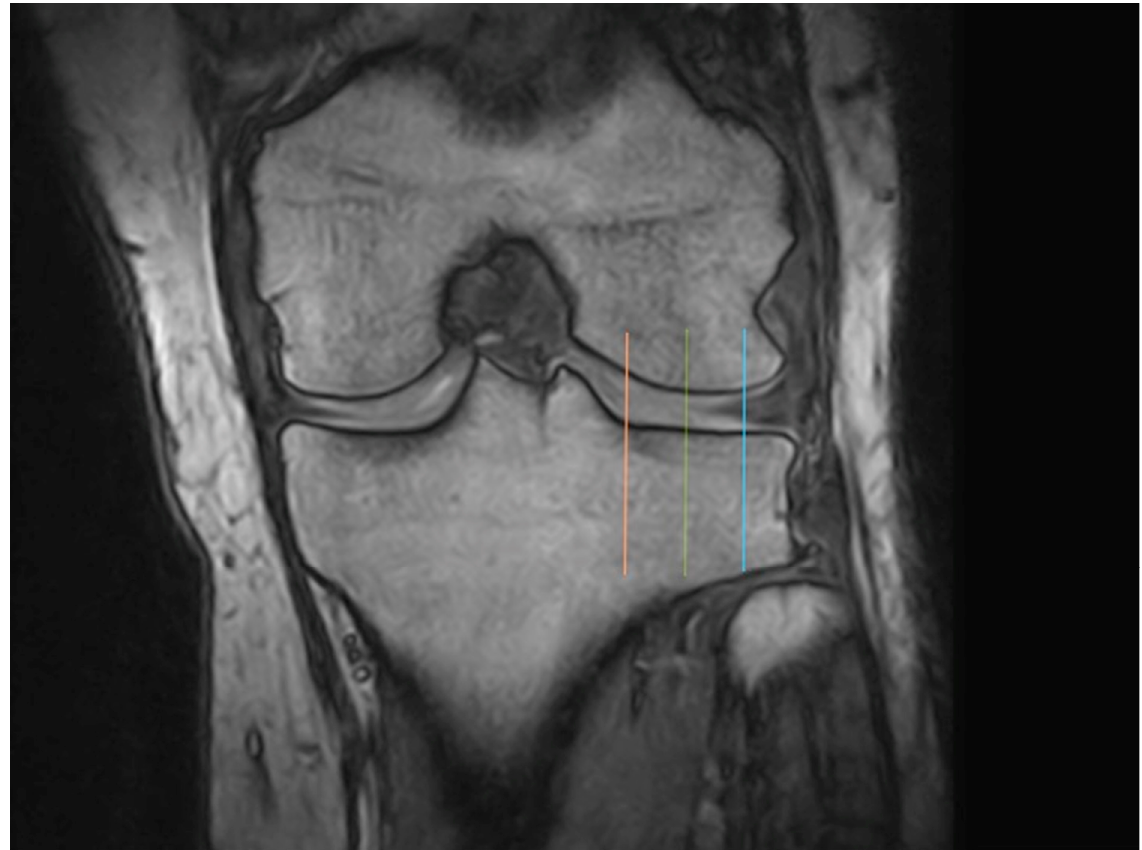
Figure 2. The plane and points of measurements for femoral and tibial condyles include three reference points in frontal view: center of the condyle (green line); 5.7 mm medial from the midline (orange line); and 5.7 mm lateral to the midline of the condyle (blue line).